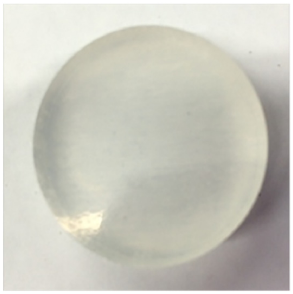
Figure 2. Sample for nanomechanical testing.